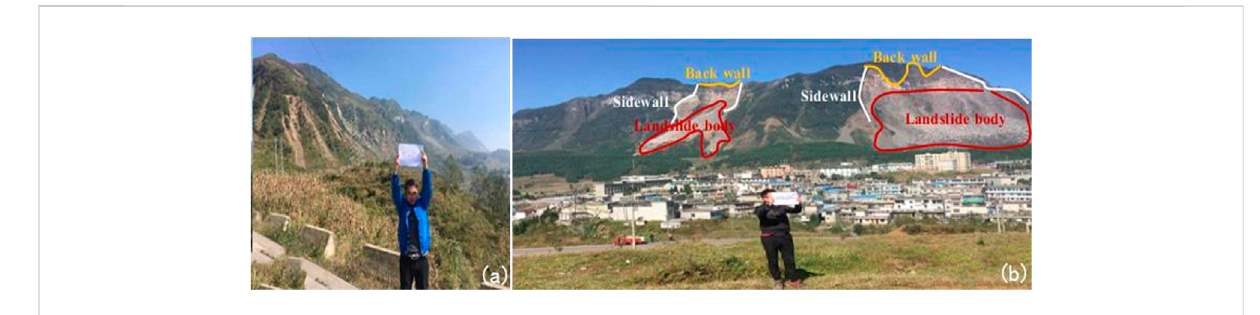
FIGURE 8 The DInSAR results of Zongling.